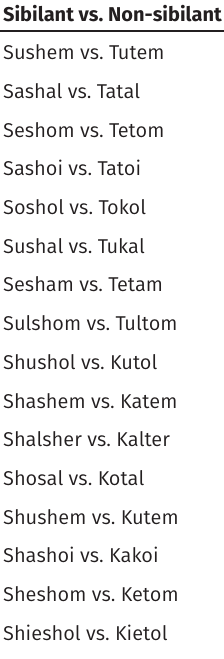
Table 1: List of stimuli used in Experiment